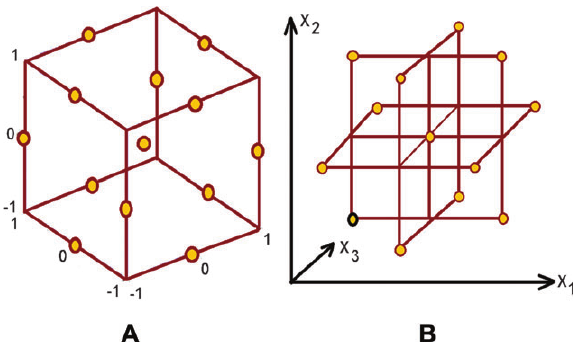
Figure 1 Box-Behnken design matrix: (A) a cubical design and (B) interlocking 2 2 factorial